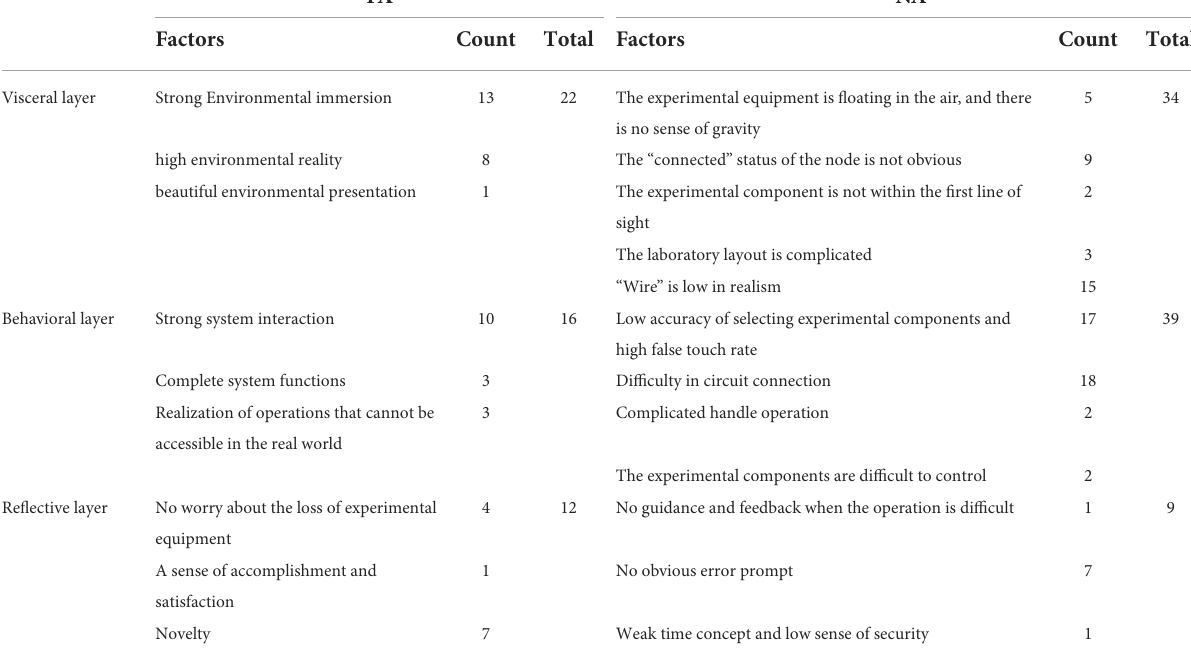
TABLE 4 Factors that linked to affective